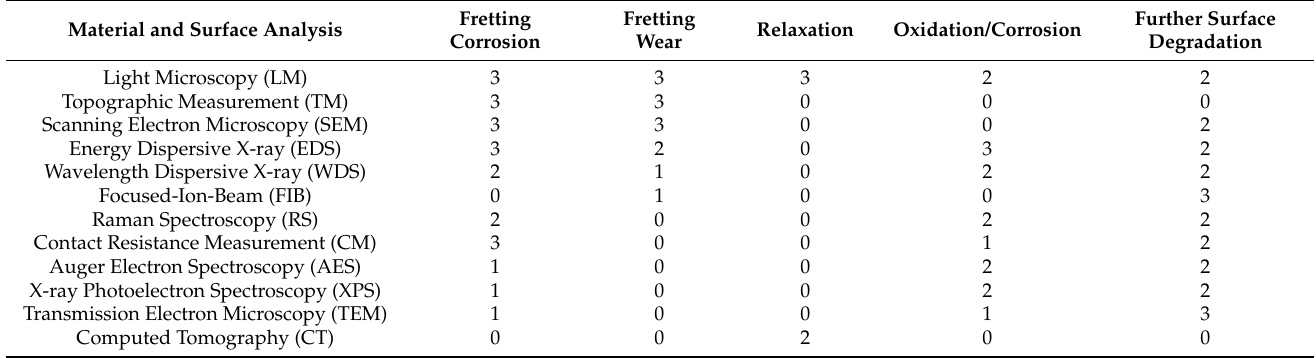
Table 5. Evaluation of the use and combination of analytical methods in relation to the cause of failure for electrical